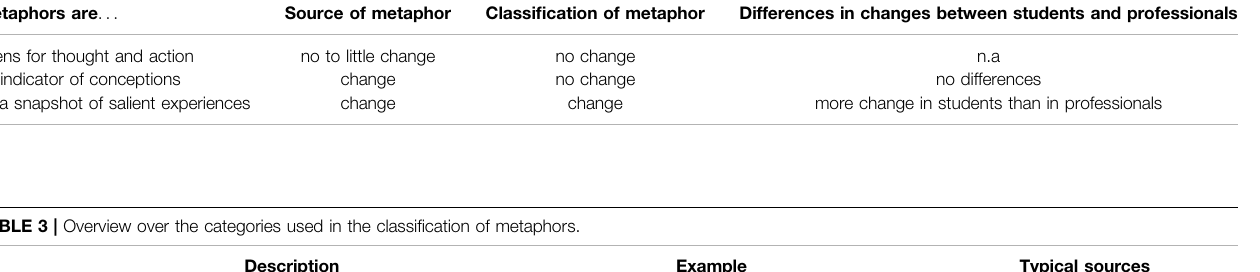
TABLE 2 | Expected outcomes for each of the three alternative hypotheses. Metaphors are ...